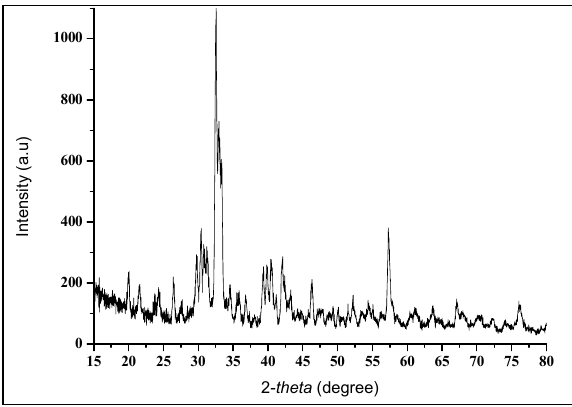
Figure 4. XRD patterns of potassium ferrate (VI) (standard).